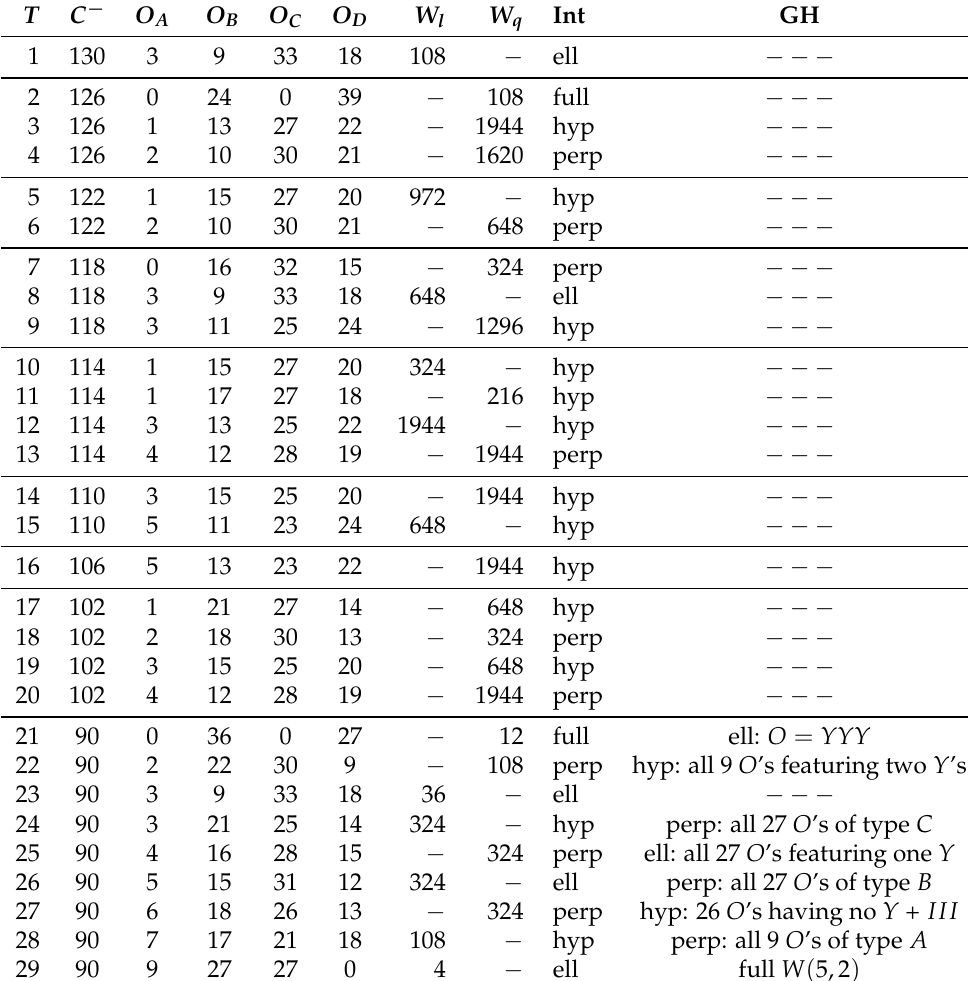
Table 5. Classification of W ( 5,2 ) ’s living in W ( 7,2 ) . Column one ( T ) shows the type, column two ( C − ) the number of negative lines in a W ( 5,2 ) of the given type, columns three to six ( O A to O D ) indicate the number of observables featuring three I ’s, two I ’s, one I or no I , respectively, columns seven ( W l ) and eight ( W q ) yield, respectively, the number of ‘linear’ and ‘quadratic’ W ( 5,2 ) ’s of a given type, the last but one column depicts the type of intersection of a representative W ( 5,2 ) with the distinguished hyperbolic quadric and the last column indicates the type of geometric hyperplane featuring the trivial mark ( I ) for composite W ( 5,2 )